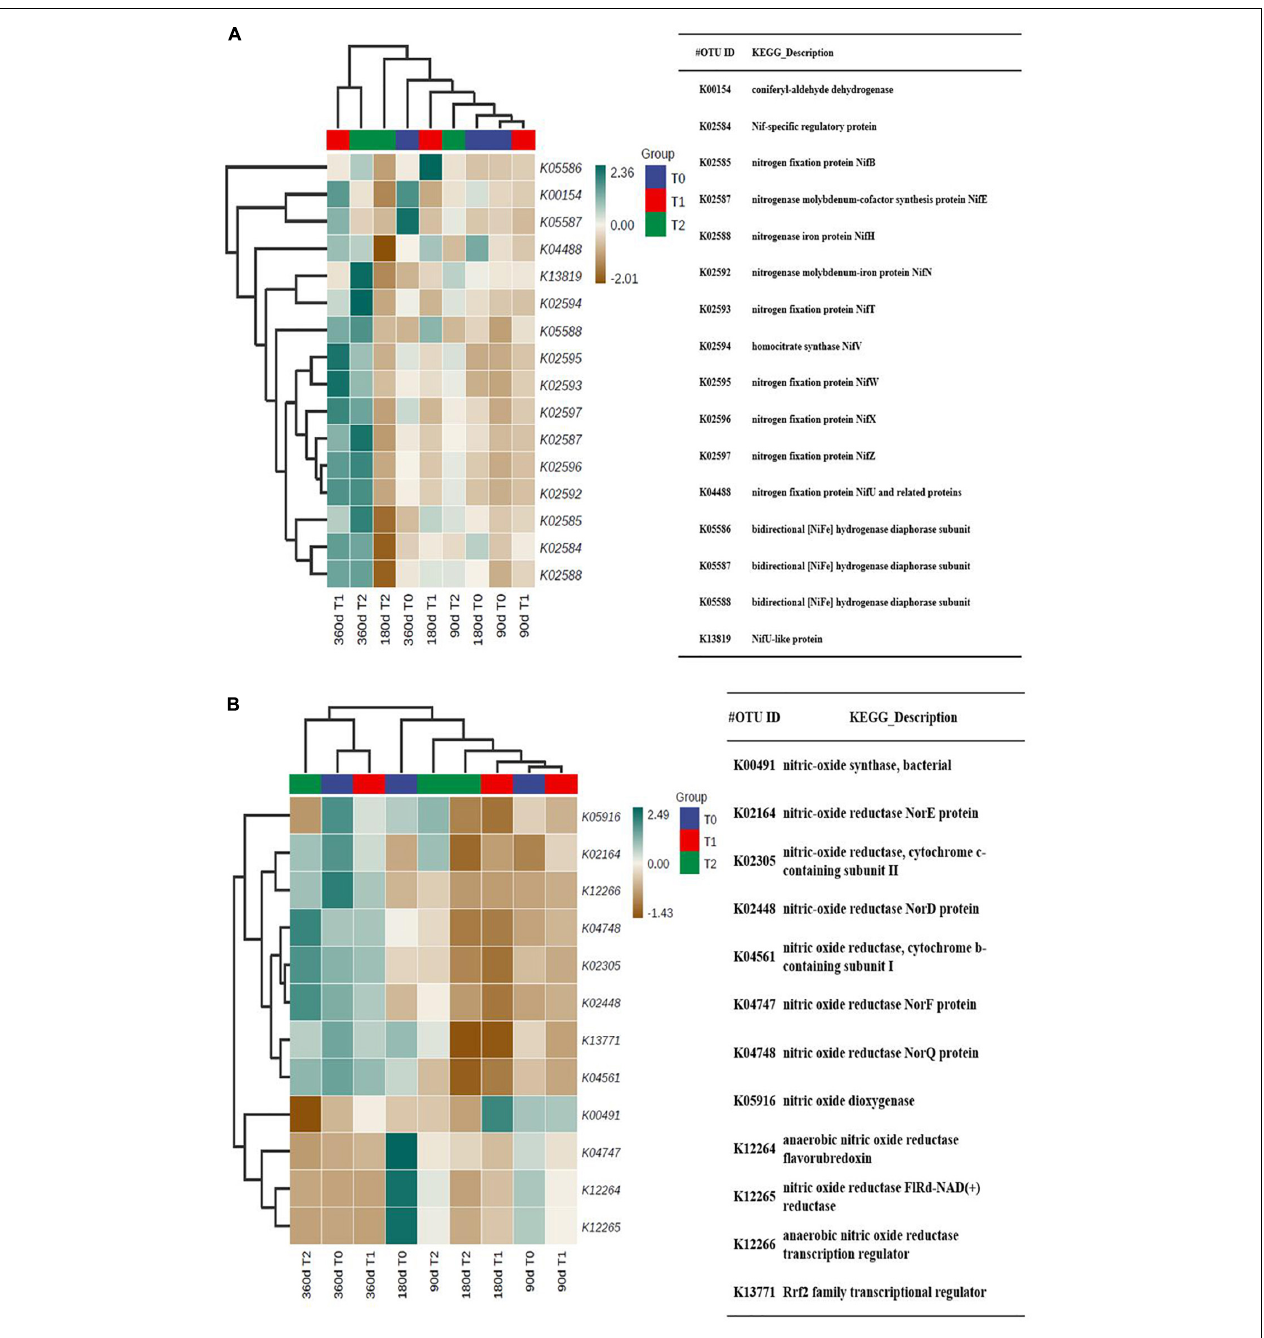
FIGURE 8 | The predicted (A) N fixation-related functions and (B) denitrification-related functions in the microbial communities in the tailing sand samples. T0, iron tailing sand + soil; T1, iron tailing sand + soil + Pennisetum giganteum ; T2, iron tailing sand + soil + bio-matrix pot + Pennisetum giganteum . 90 d, 180 d, and 360 d indicate the sampling time in days after the start of the